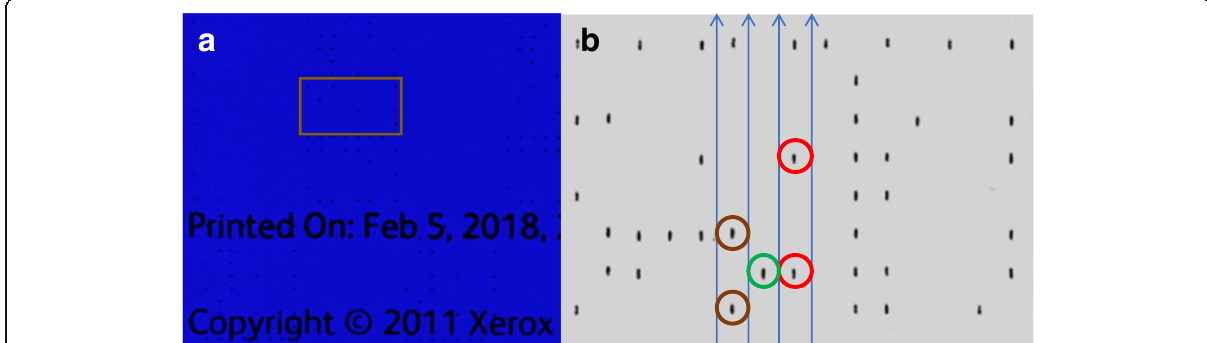
Fig. 11 ( a ) The RGB mode representation of the actual printed date of the printing process in black dots, ( b ) The grayscale representation for the calculated date (5/2/2018) in red, green and brown circles